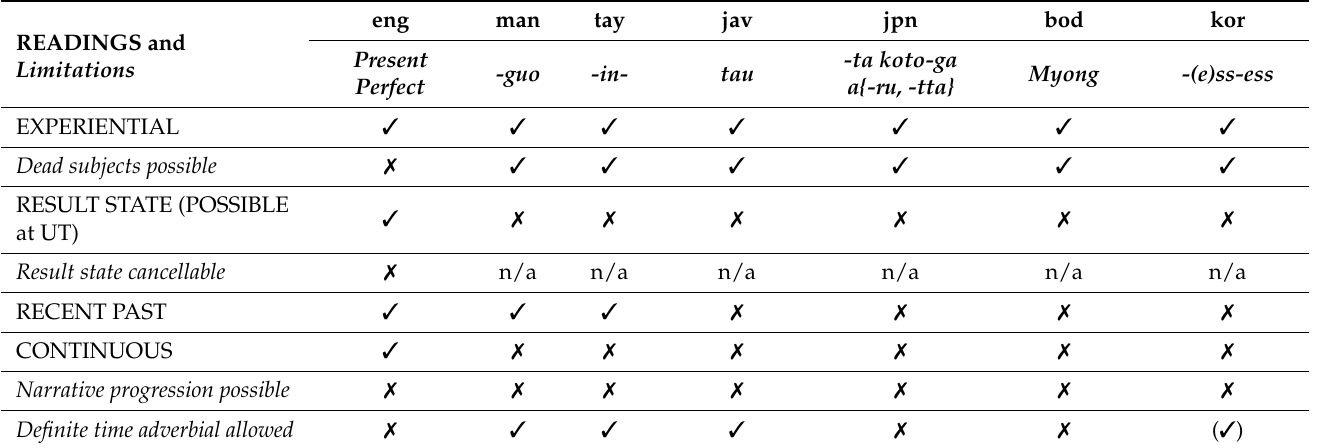
Table 3. Experiential